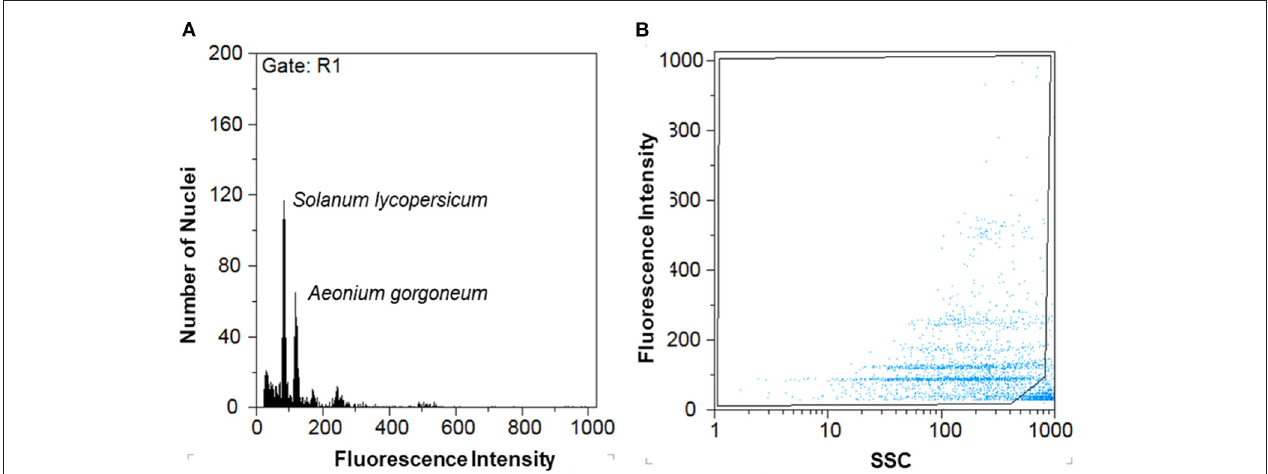
FIGURE 5 | Flow cytometry outputs: (A) Flow cytometric histogram of relative fluorescence intensities from propidium iodide-stained Aeonium gorgoneum nuclei using Solanum lycopersicum (2C-value = 1.96 pg DNA) as an internal reference standard. (B) Dot-plot of SSC vs. FL presenting the gating made to exclude as much as possible partial nuclei and other types of